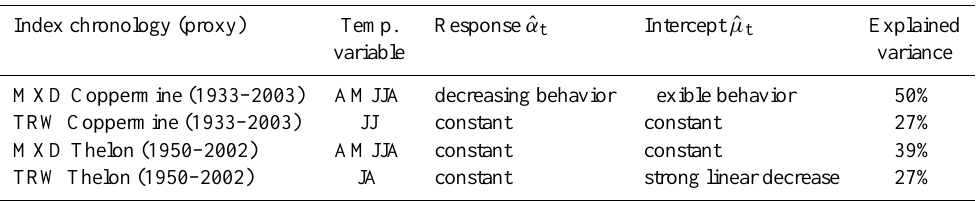
Table 1. Stability statistics for the Thelon and Coppermine TRW/MXD series. The stability descriptives are deduced from visual inspection of the SRF graphs, and were confirmed by LR tests (cf. Figs. 1 and 2).